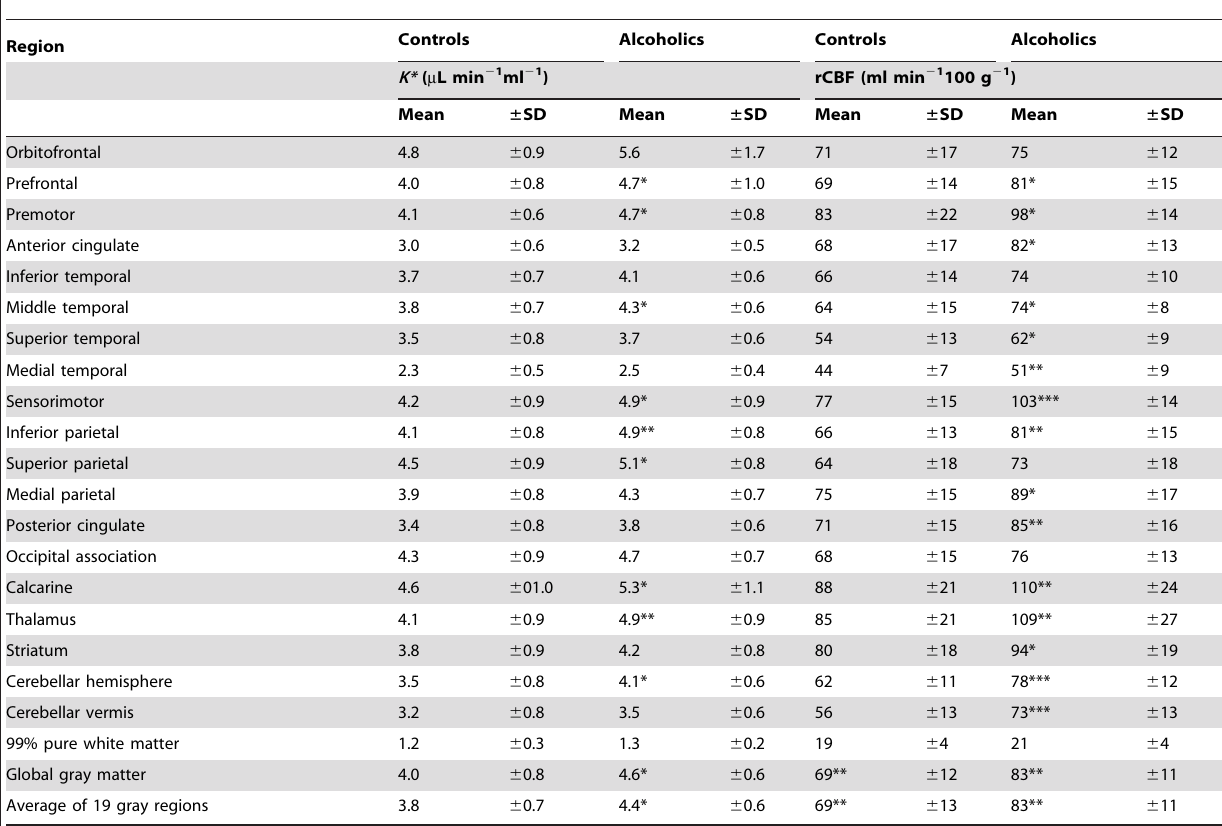
Table 2. Comparisons of regional values of K* and rCBF between alcoholics and controls.